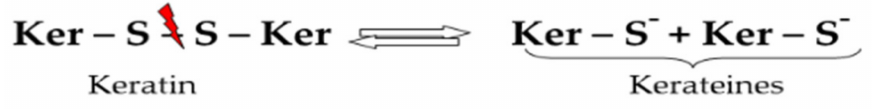
Figure 2. Reduction of keratin into